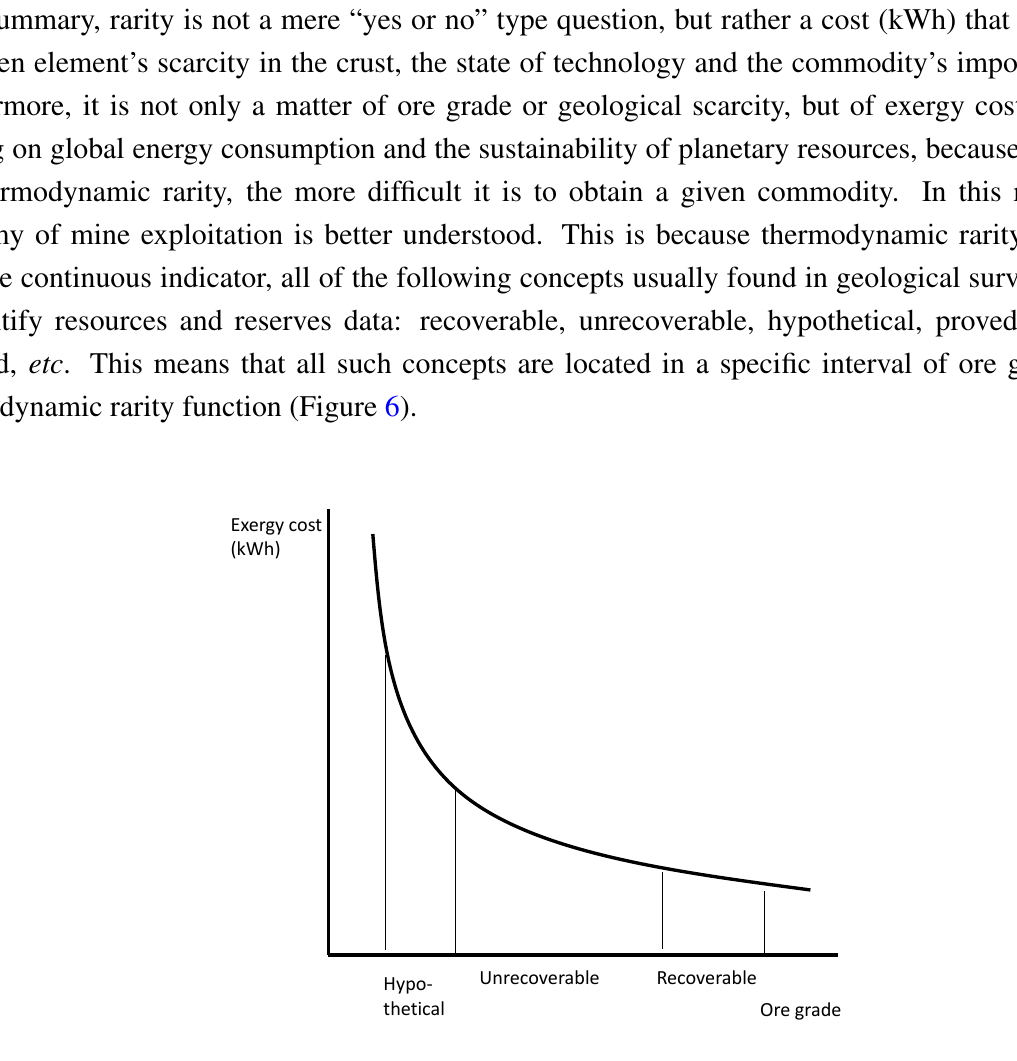
Figure 6. Resources classification as a function of the thermodynamic rarity of a given mineral